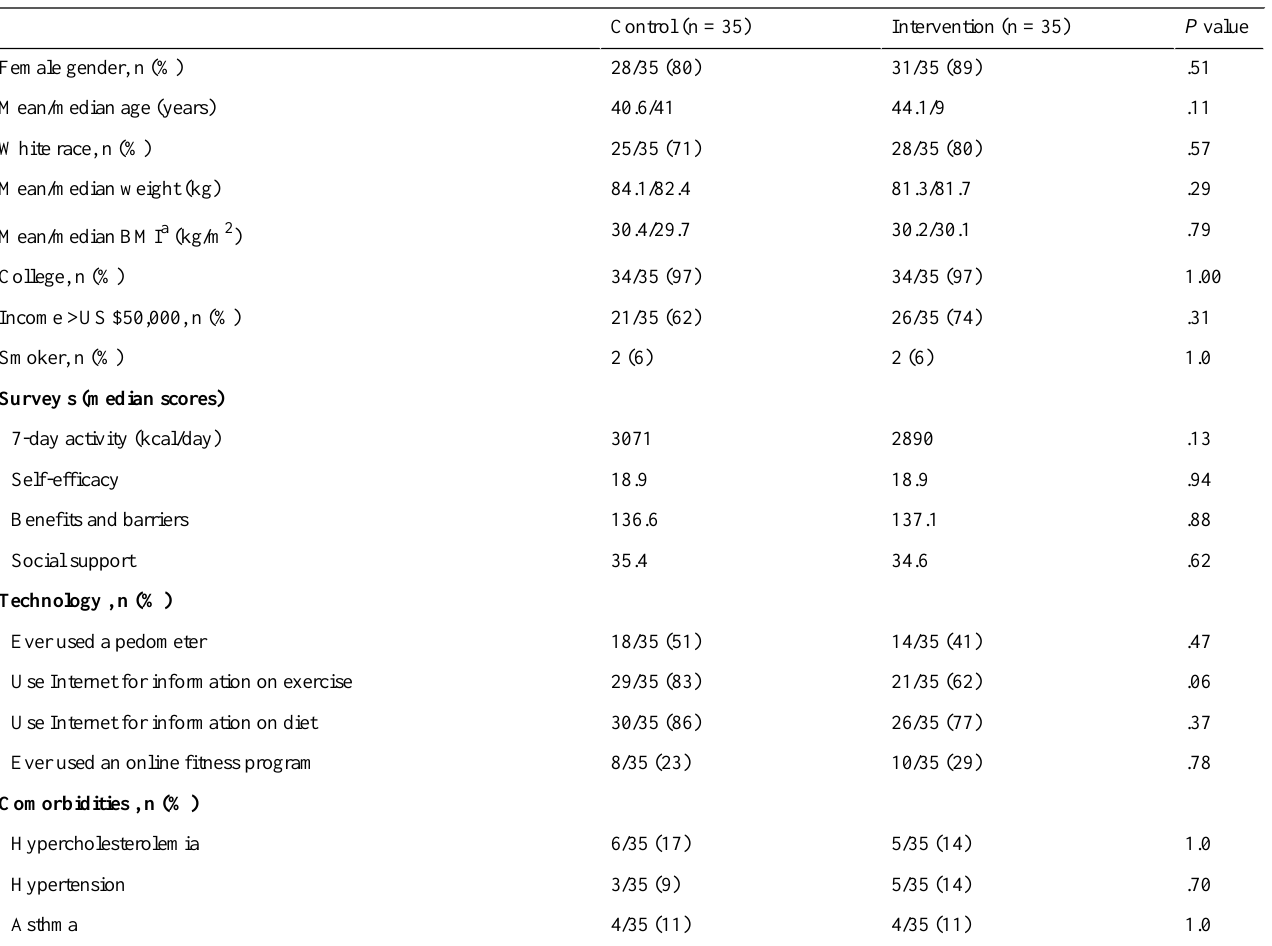
Table 1. Baseline demographics of study